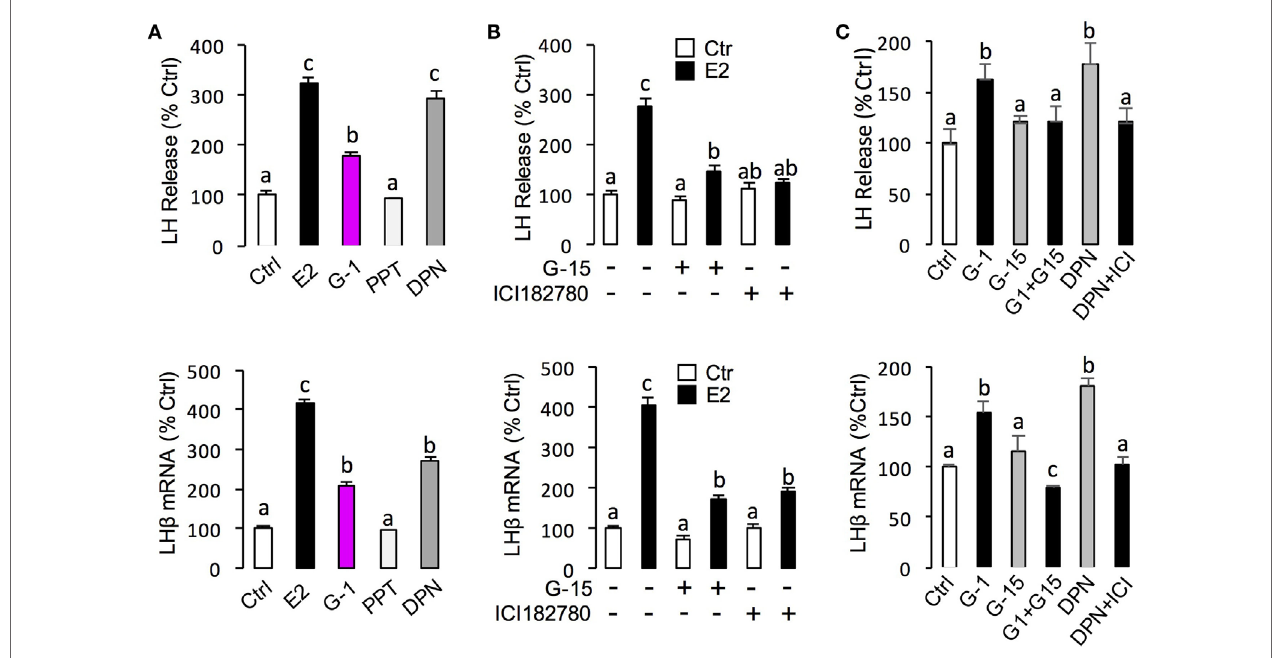
FigUre 4 | Receptor specificity of E2-induced luteinizing hormone (LH) secretion and mRNA expression. (a) Effects of ER agonists on LH transcript expression and hormone secretion. For LH β mRNA expression, pituitary cells were treated for 24 h with E2 (10 nM), G protein-coupled estrogen receptor (GPER) agonist G-1 (1 µM), estrogen receptor alpha agonist propylpyrazole triol (PPT) (1 µM), and ER β agonist DPN (1 µM), respectively. (B) Effects of GPER antagonist G-15 and ER antagonist ICI182780 on E2-induced LH β secretion and mRNA expression. Pituitary cells were treated for 24 h with E2 (10 nM) in the presence or absence of the G-15 (10 µM) or ICI182780 (10 µM), respectively. (c) Effects of GPER antagonist G-15 or ER antagonist ICI182780 on G-1- or DPN-induced LH secretion and mRNA expression. Grass carp pituitary cells were incubated for 24 h with GPER agonist G1 (1 µM) in the presence or absence of G-15 (10 µM), or ER β agonist DPN (1 µM) in the presence or absence of ICI182780 (10